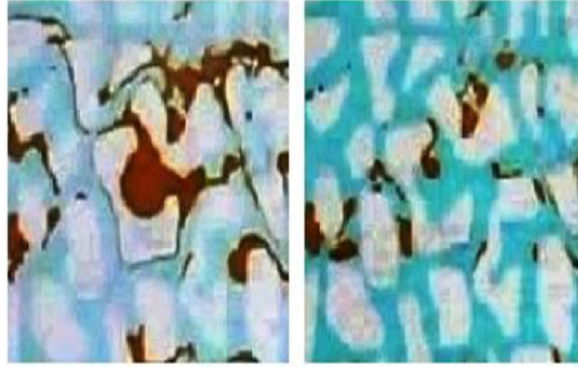
Fig. 8 Trapped oil production during CWI. a Before tertiary CWI and b after tertiary CWI (Mosavat